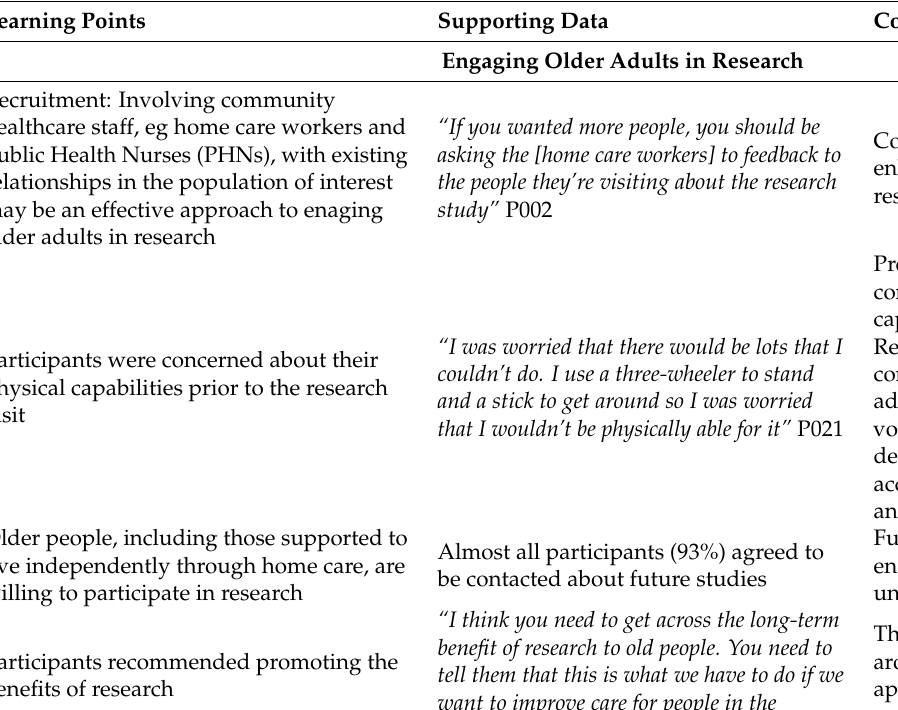
Table 2. Learnings for future in-home research engaging community-dwelling older adults with dependency based on participant feedback ( n =